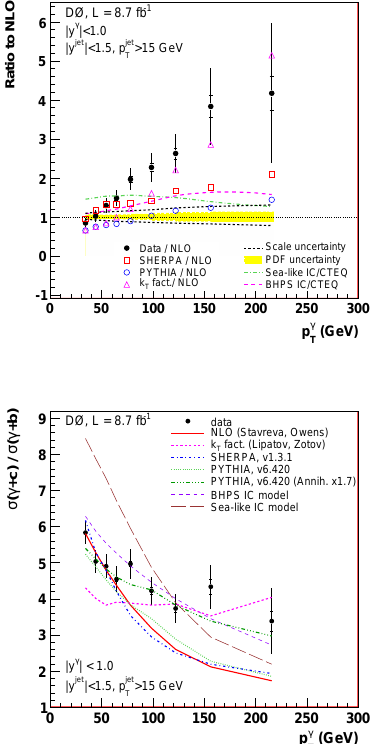
γ + c -jet di ff erential cross sections between data and NLO predictions with uncertainties for the rapidity re- y γ < 1 . 0 (Upper). The uncertainties on the data include gions | | both statistical (inner error bar) and full uncertainties (entire er- ror bar). The ratio of di ff erential cross sections for γ + c -jet to γ + b -jet production